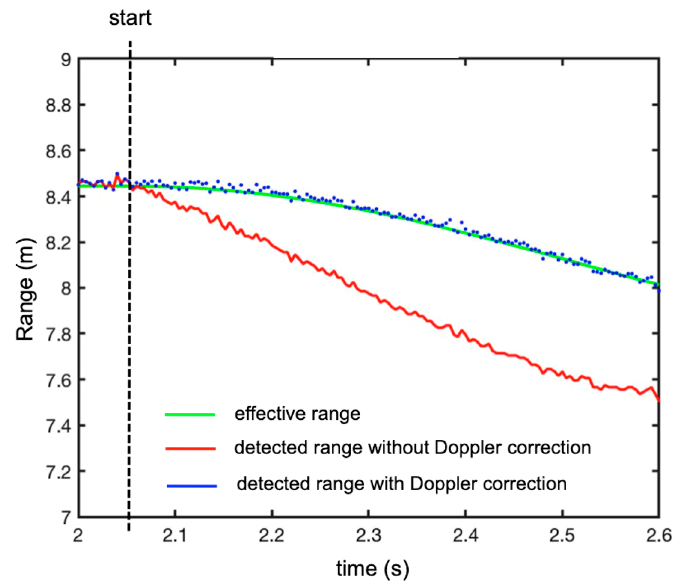
Figure 7. Plot of the peak range in time. The green line is the effective range of the target, the red line is the range of the peaks without the Doppler correction, and the blue dotted line is the range of the peaks with the Doppler correction.